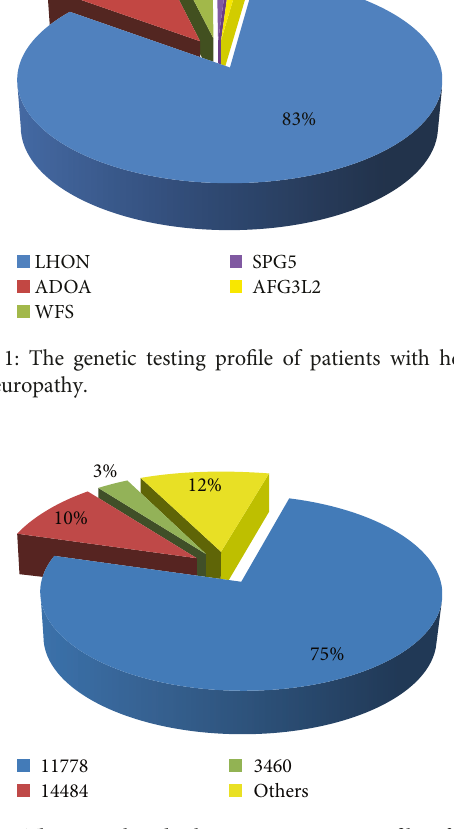
Figure 2: The mitochondrial DNA mutation pro fi le of patients with